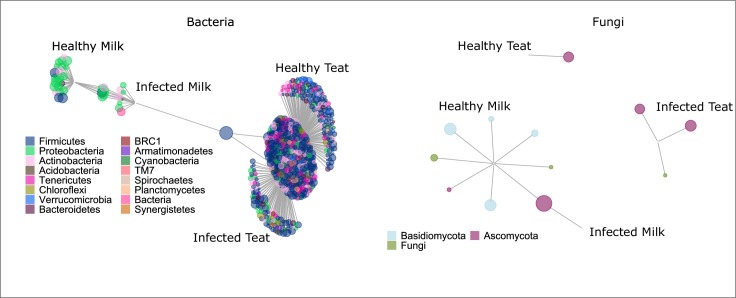
Bipartite networks of bacterial and fungal OTUs associated with one or multiple habitat states (infected milk, healthy milk, infected teat, healthy teat) in sampling year 2015.OTUs are included if chance of no association is p ≤ 0.05 as tested by indicator species analysis. Gray lines indicate association between habitat state(s) and OTUs (points). OTUs are colored by phylum and displayed on a log scale. The Firmicutes OTU connecting infected milk and teat is Staphylococcus OTU_001. The Ascomycota OTU connecting healthy and infected milk is Penicillium olsonii.